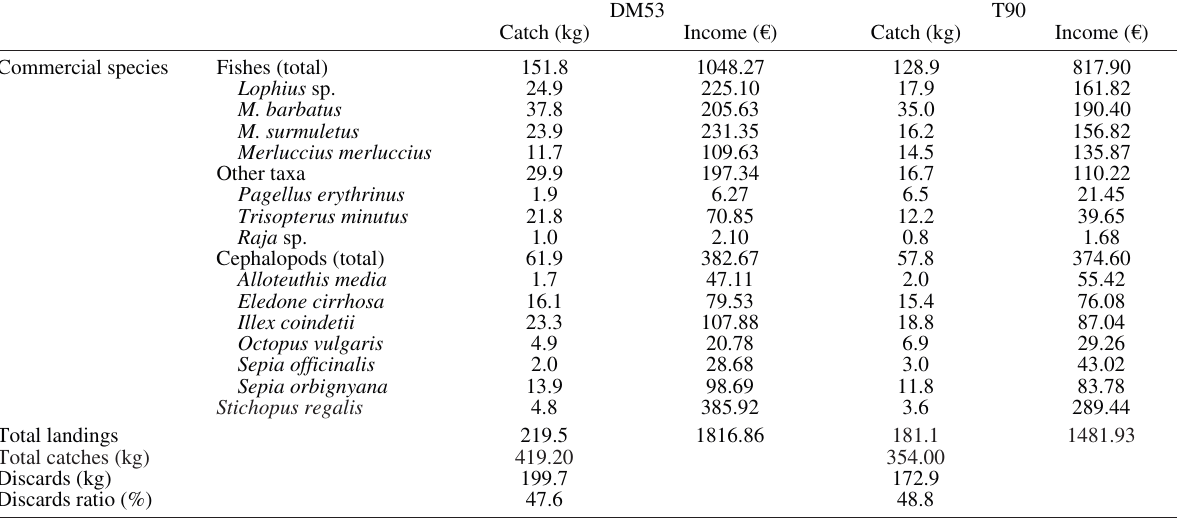
Table 5. – Mean catch composition (weight and value) of 12 hauls with the standard net (DM53) and with the experimental net (T90). Income shown is the ex-vessel value.